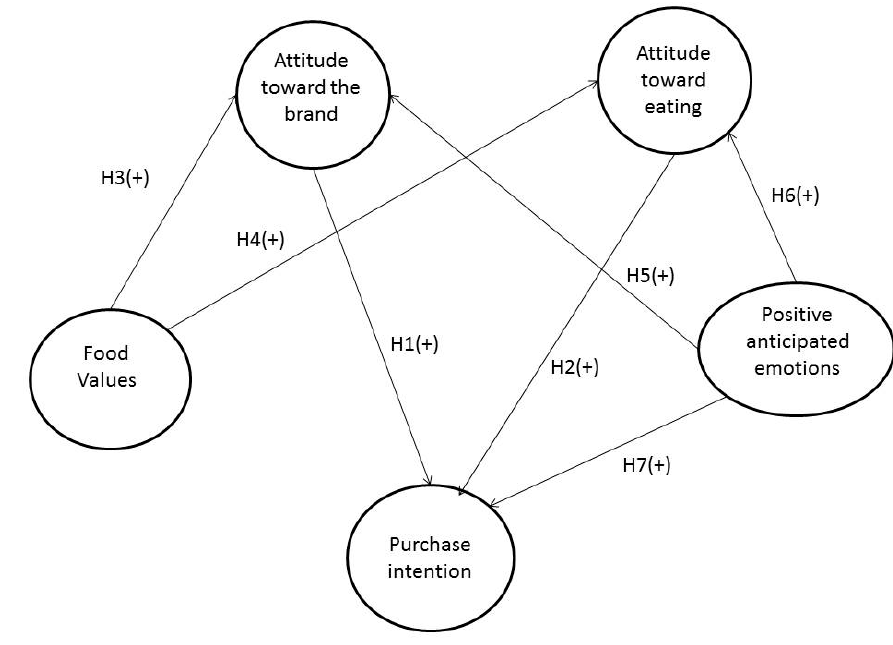
Figure 1. Model development.